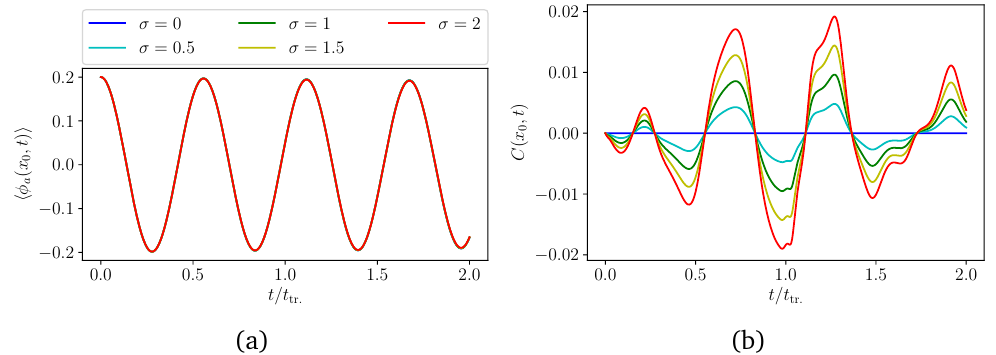
Figure 3: (a) time evolution of the phase in the antisymmetric sector at the box centre = L / 2. Curves are displayed for different values of σ , with a flat initial density x 0 ( x ) 〉 = 0. A change of σ has no appreciable effect on this observable. (b) profile 〈 Π s a somewhat stronger effect is the development of correlations between φ the normalized covariance from Eq. (82) is displayed, for x